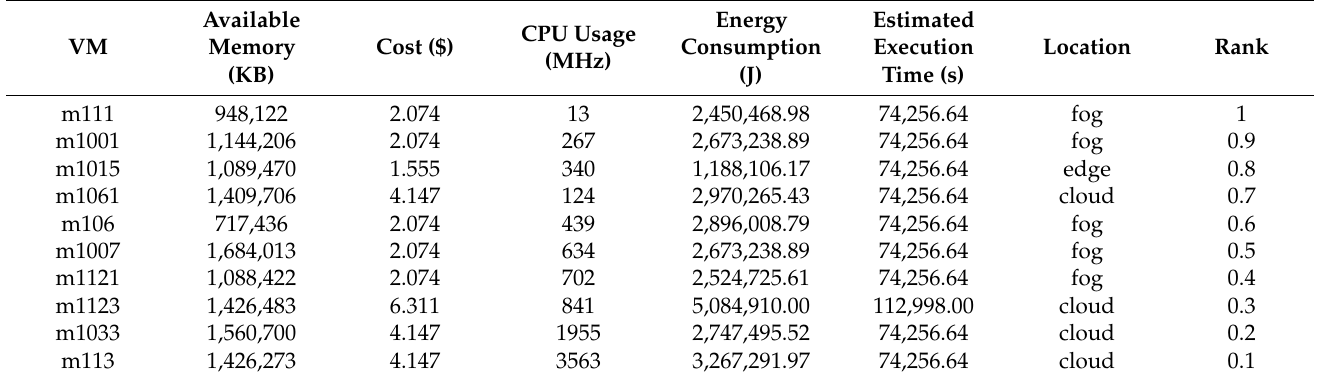
Table 17. Optimization results Task 318037 with CPU utilization use case and cost-driven use case